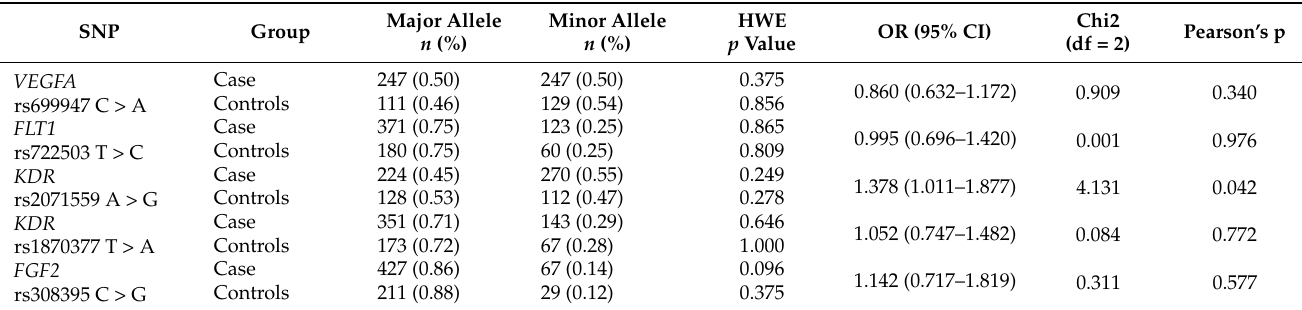
Table 2. Distribution of SNPs alleles in study